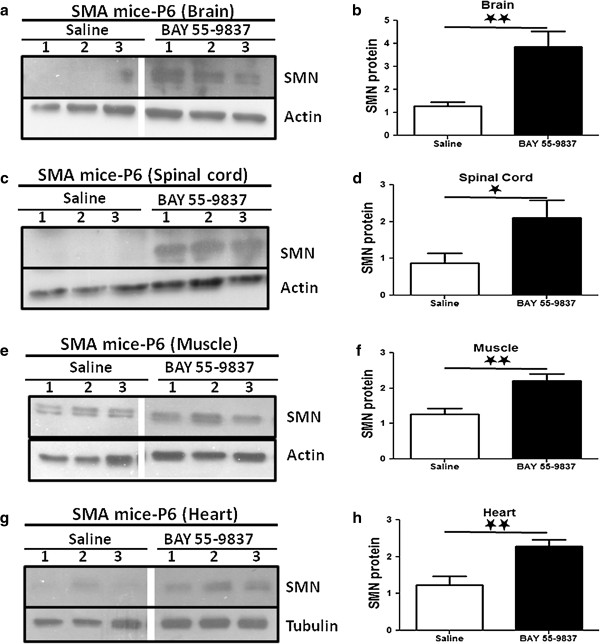
BAY 55-9837 upregulates SMN protein in SMA mouse model. SMA∆7 mice were treated daily with saline or BAY 55-9837 (200 μg/kg) from P1 for 6 days, then sacrificed at P7. Brain, spinal cord,skeletal muscle and heart tissues were harvested for western blot analysis. Representative western blots showing effect of BAY 55-9837 on SMN protein in brain (a), spinal cord (c), muscle (e) and heart (g) samples of SMA∆7 mice treated with Saline (control, lane 1, 2 & 3) or BAY 55-9837 (treatment lane 1, 2 & 3 respectively) (each lane represents individual animal; all lanes were run on the same gel but were non-contiguous). Densitometric quantification of SMN relative to Actin/Tubulin [mean + SEM (bars)] is shown for brain (b; n=11), spinal cord (d; n=6), muscle (f; n=11) and heart (h; n=11) samples. *P < 0.05; **P < 0.01; t-test.